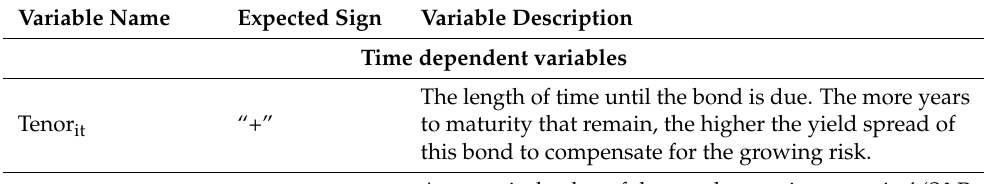
Table 2. Dependent variables in the